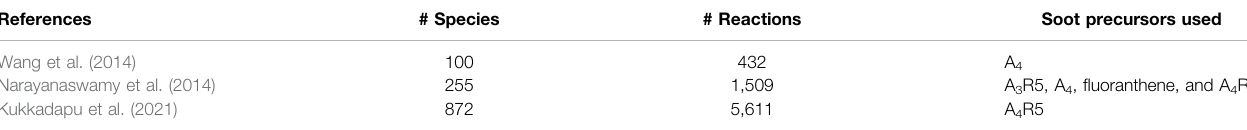
TABLE 2 | Chemical mechanisms from the literature used in